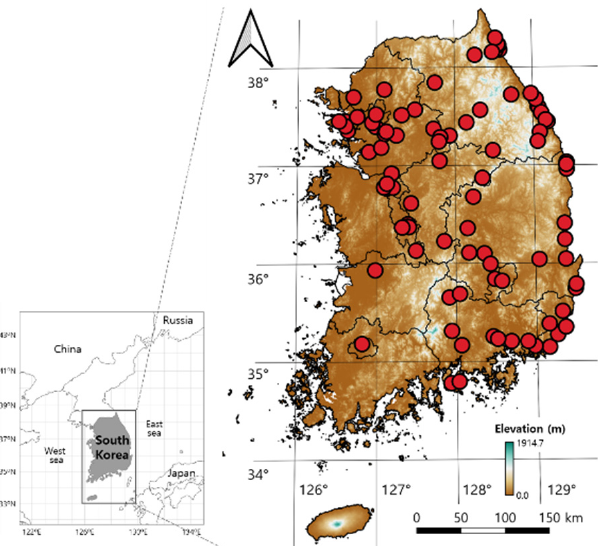
Figure 1. Distribution of WCSB occurrence (red points) in South Korea. These are the points after performing spatial